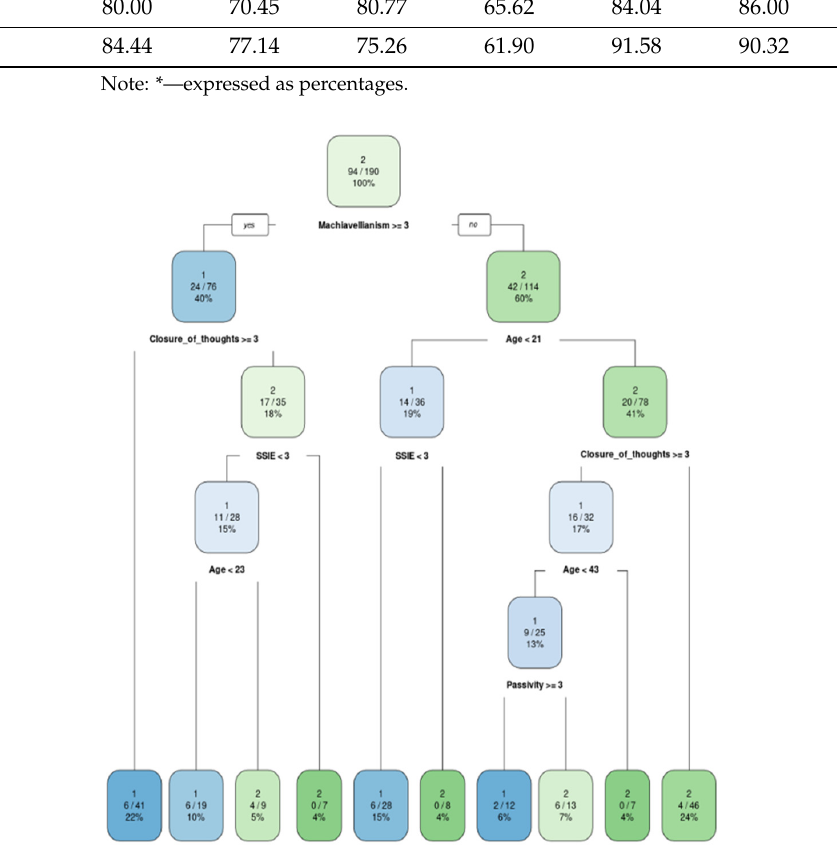
Figure 1. Classification model for a stay in the shopping gallery: 1—wearing a mask; 2—not wearing a mask.